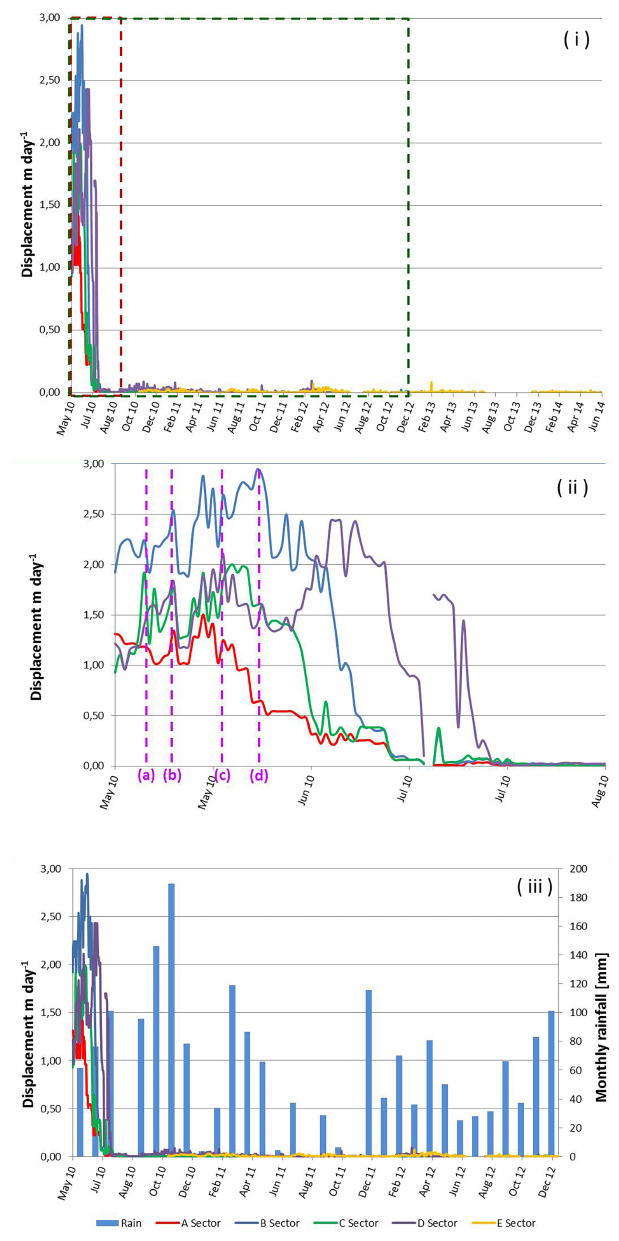
Figure 16. (i) Recorded velocity at the different sectors. (ii) The 2mday − 1 threshold was exceeded on the following days: (a) 10 May 2010, sector B reached 2.2mday − 1 ; (b) 14 May 2010 the sector B velocity was recorded up to 2.5mday − 1 , sectors A, C and D were affected by a lower but comparable trend; (c) between 24 and 25 May, sectors B, C and D reached the velocity of 2.3, 2 and 2.1mday − 1 , respectively; (d) maximum velocity recorded was 2.9mday − 1 on 31 May 2010. (iii) Recorded velocity at the differ- ent sectors compared with the monthly cumulated